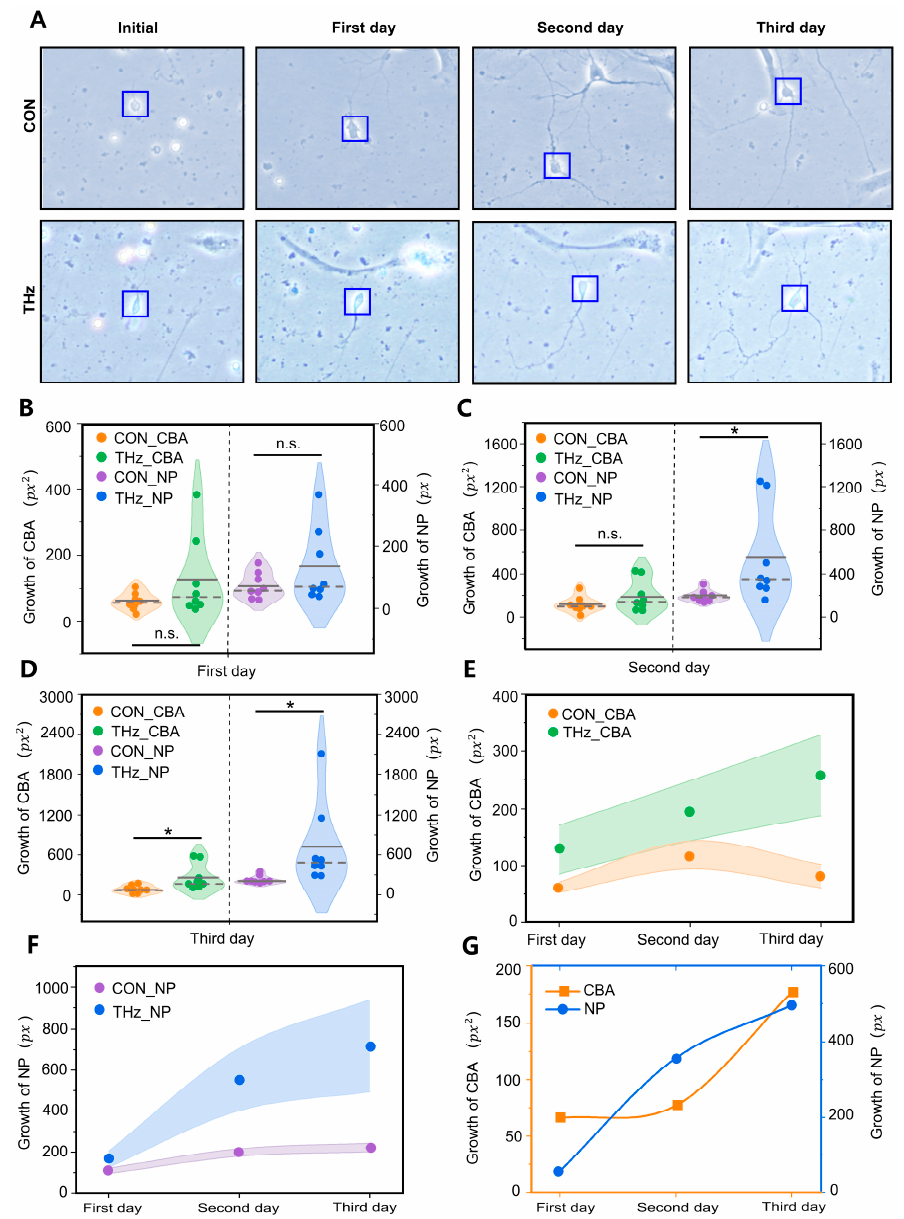
Figure 2. Terahertz radiation promotes the dynamic growth and development of cortical neurons. ( A ) Representative performance maps of neuronal developmental status in the terahertz (THz) and control (CON) groups. ( B – D ) On the second day of terahertz radiation, neurite protrusion (NP) growth was significantly higher than the CON. On the third day of THz radiation, the growth values of both NP and cell body area (CBA) were signi fi cantly higher than CON. Data are mean ± SEM ( n = 8 independent experiments). *, p < 0.05 compared with control, n.s. indicates no signi fi cant di ff er- ence. independent samples t -test. ( E , F ) The growth values of NP and CBA after THz radiation of the neurons were correlated with the number of days of radiation. However, this phenomenon was not observed in the CON. ( G ) Relationship between the radiation days in THZ_CBA minus CON_CBA and THZ_NP minus CON_NP.